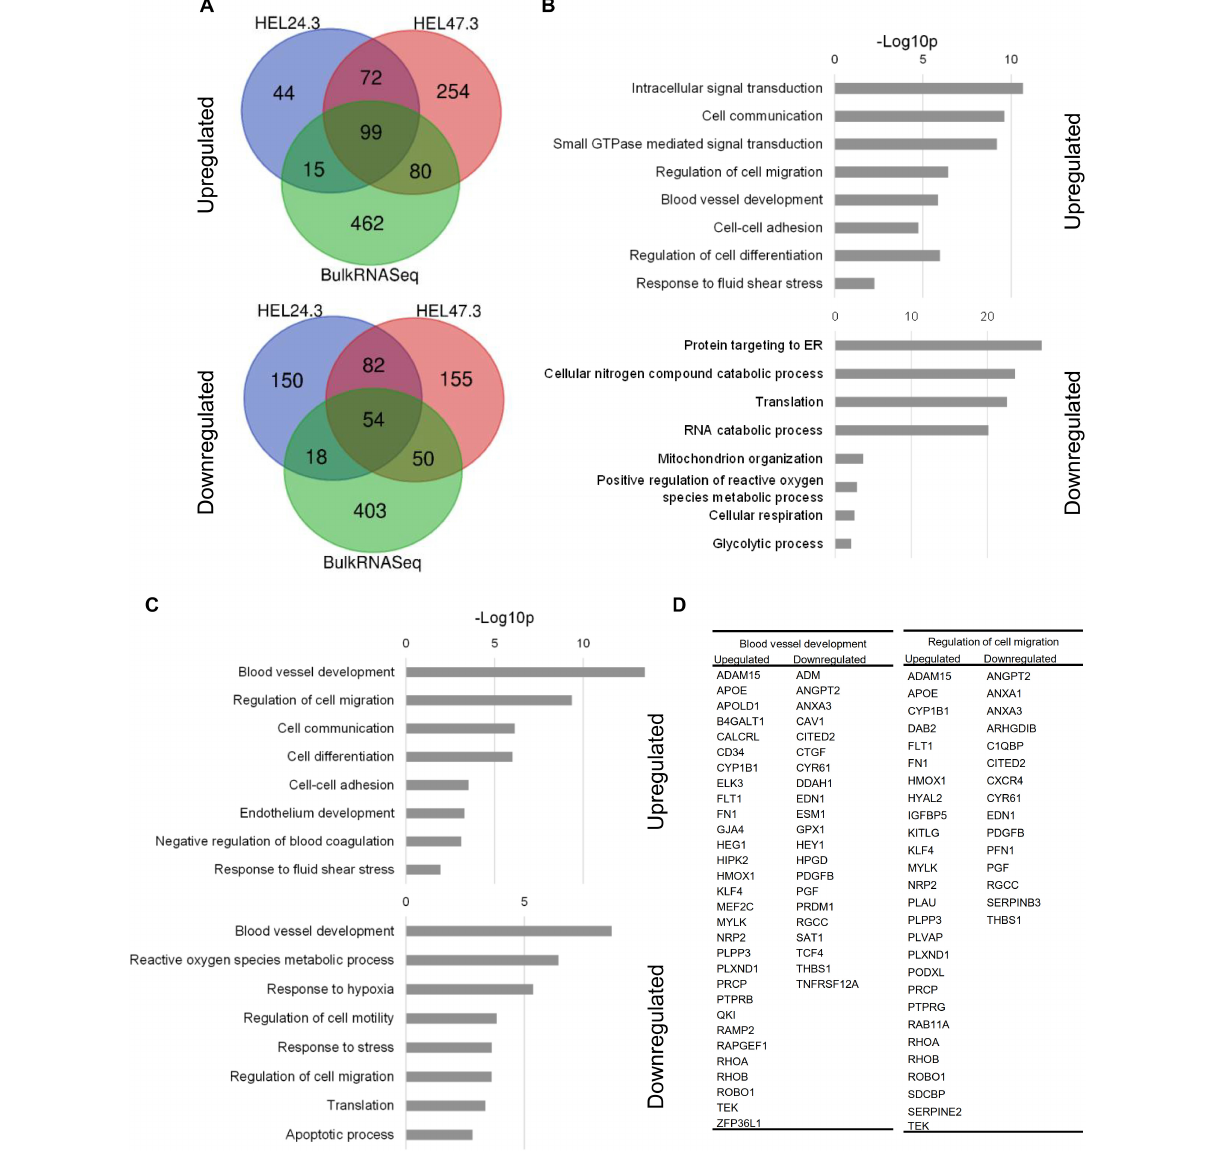
FIGURE 4 | Gene Ontology (GO) analysis of the scRNASeq and bulk RNASeq data (DAVID Bioinformatics Resources). (A) , Venn diagram of upregulated and downregulated genes shared between scRNASeq and bulk RNASeq. (B) , Upregulated and downregulated GO terms in bulk RNASeq data (C) , Upregulated and downregulated GO terms in scRNASeq data. (D) , A list of genes included in the GO term categories that were both upregulated and